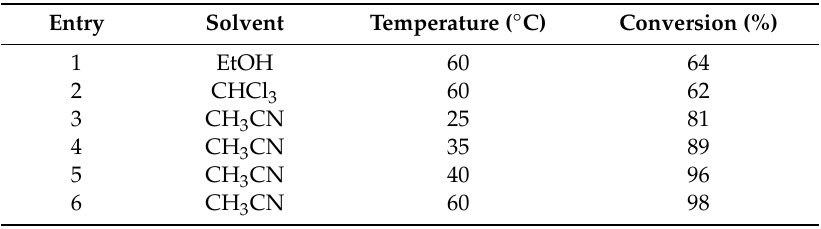
Table 2. E ff ect of solvents on the epoxidation of cyclooctene over catalyst 1 .